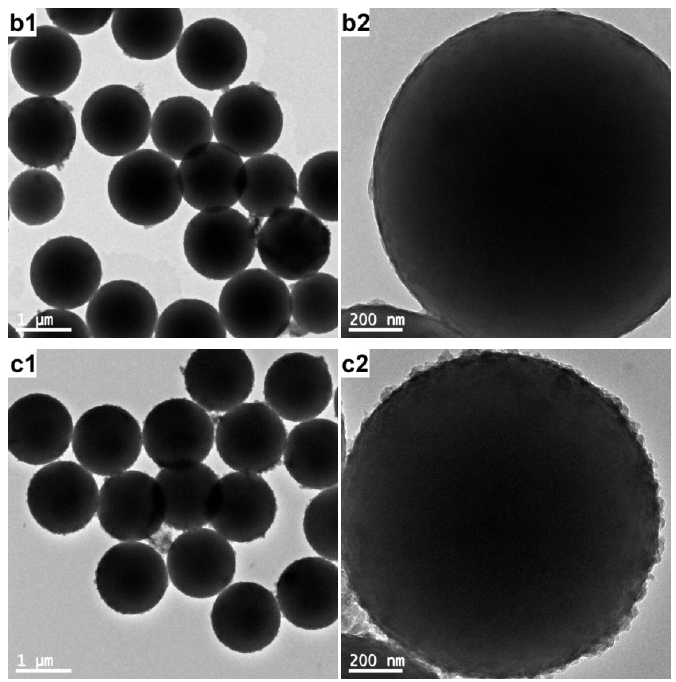
Figure 7. TEM images of the products prepared with varied PS amounts and a fixed amount of AT (0.2 g) at various magnifications: ( a ) 0.2 g (run 5); ( b ) 0.1 g (run 6), and ( c ) 0.05 g (run 7).